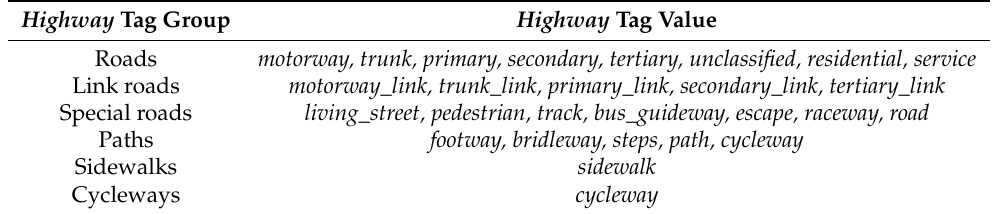
Table 3. Major highway tag of an OSM